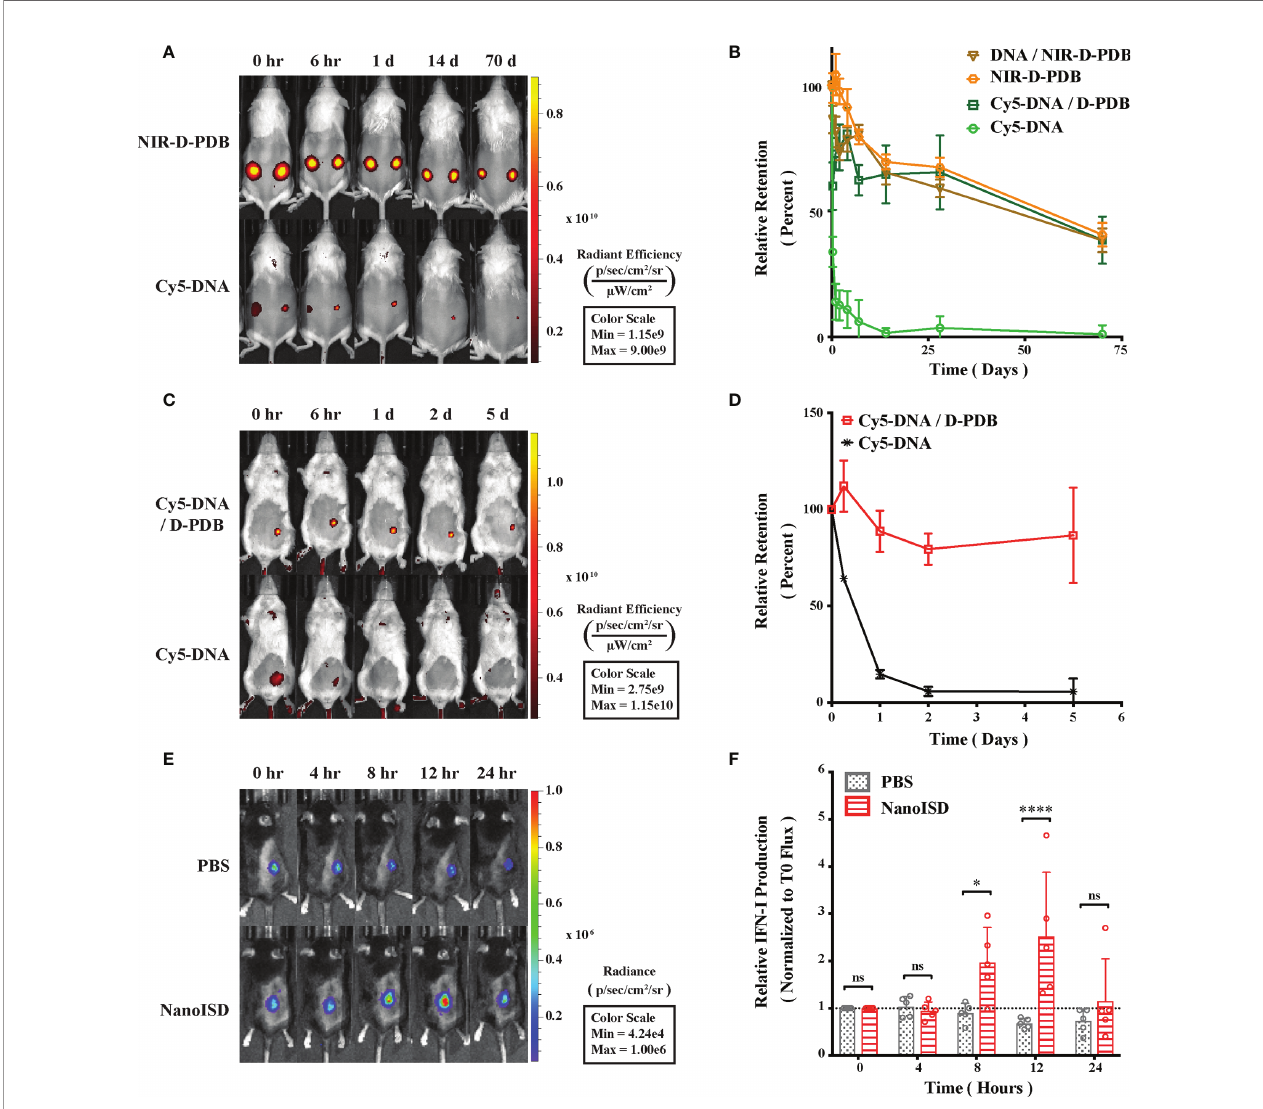
FIGURE 5 | NanoISD Enhances Delivery and Immunostimulatory Activity of ISD In Vivo . (A) Representative fl uorescence IVIS images evaluating the subcutaneous retention of NanoISD in CD-1 mice. D-PDB labeled with NIR-664-iodoacetamide ( i.e. NIR-D-PDB) was used to track the polymer, and phosphorothioate-capped 95- BP dsDNA labeled with Cy5 ( i.e. Cy5-DNA) was used to track the DNA. On the left fl ank of each mouse, individual uncomplexed agents were administered, and on the right fl ank of each mouse, complexes at an N/P charge ratio of 4 with the indicated fl uorescent agent were administered. A subcutaneous injection was given as a single 100 µL dose of 2 µg DNA and/or 36 µg of polymer. (B) Retention pro fi les of NIR-D-PDB and Cy5-DNA either uncomplexed or complexed with unlabeled counterparts following subcutaneous administration in CD-1 mice. (C) Representative fl uorescence IVIS images evaluating the tumor retention of NanoISD in BALB/ cJ mice bearing orthotopic 4T1 tumors. Phosphorothioate-capped 95-BP dsDNA labeled with Cy5 ( i.e. Cy5-DNA) was used to track the DNA. Cy5-DNA was administered by itself or in complex with D-PDB at an N/P charge ratio of 4. An intratumoral injection was given as a single 100 µL dose of 2 µg DNA. (D) Retention pro fi les of Cy5-DNA complexed to D-PDB and free Cy5-labeled DNA following intratumoral administration into orthotopic 4T1 breast tumors growing in BALB/c mice. (E) Representative luminescence IVIS images evaluating tumor IFN activity in C57BL/6J mice bearing B16.F10 IFN-LUC tumors. An intratumoral injection was given as a single 100 µL dose of either PBS or NanoISD at a dose corresponding to 2 µg DNA. (F) Longitudinal analysis of IFN activity following treatment. A two- way ANOVA with Sidak test was used for statistical analysis. ****p < 0.0001, *p < 0.05. ns, not signi fi